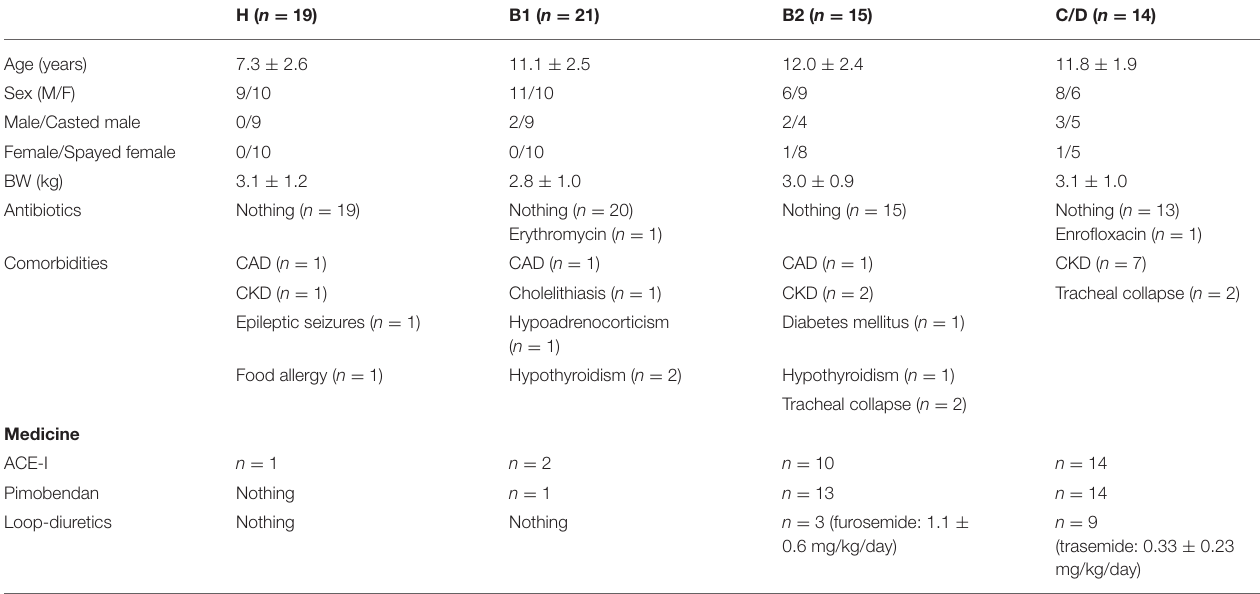
TABLE 1 | Patient characteristics of healthy Chihuahuas (H) and Chihuahuas with myxomatous mitral valve disease divided into three groups (B1, B2, and